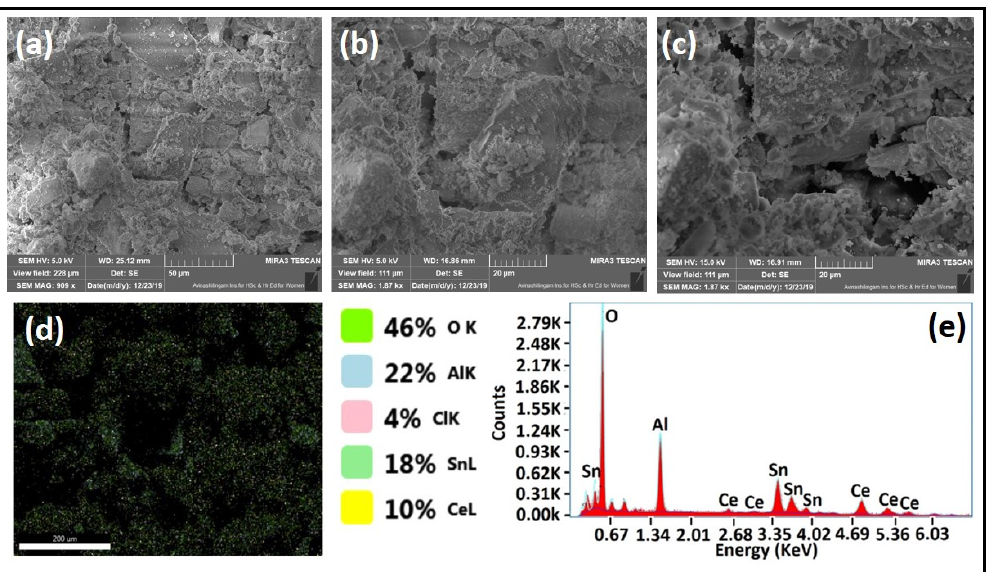
Figure 7. ( a – c ) SEM micrographs of CTA-55, ( d ) elemental mapping of CTA-55, and ( e ) EDS spectra of CTA-55.